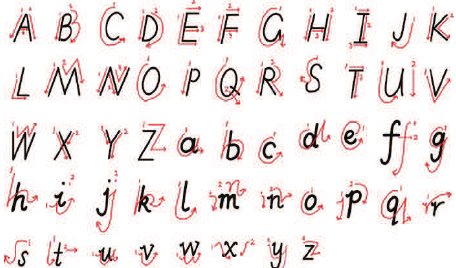
Figure 9. The normalized manner of handwritten